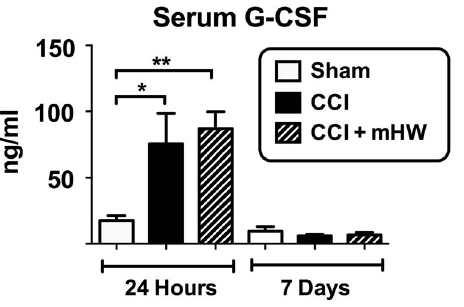
Figure 6. Effects of CCI and mHW on Serum Cytokine Levels. Only G-CSF was elevated in blood after CCI and only at 24 h. There was no statistically significant effect of mHW on serum G-CSF levels. *p , 0.05; **p , 0.01.